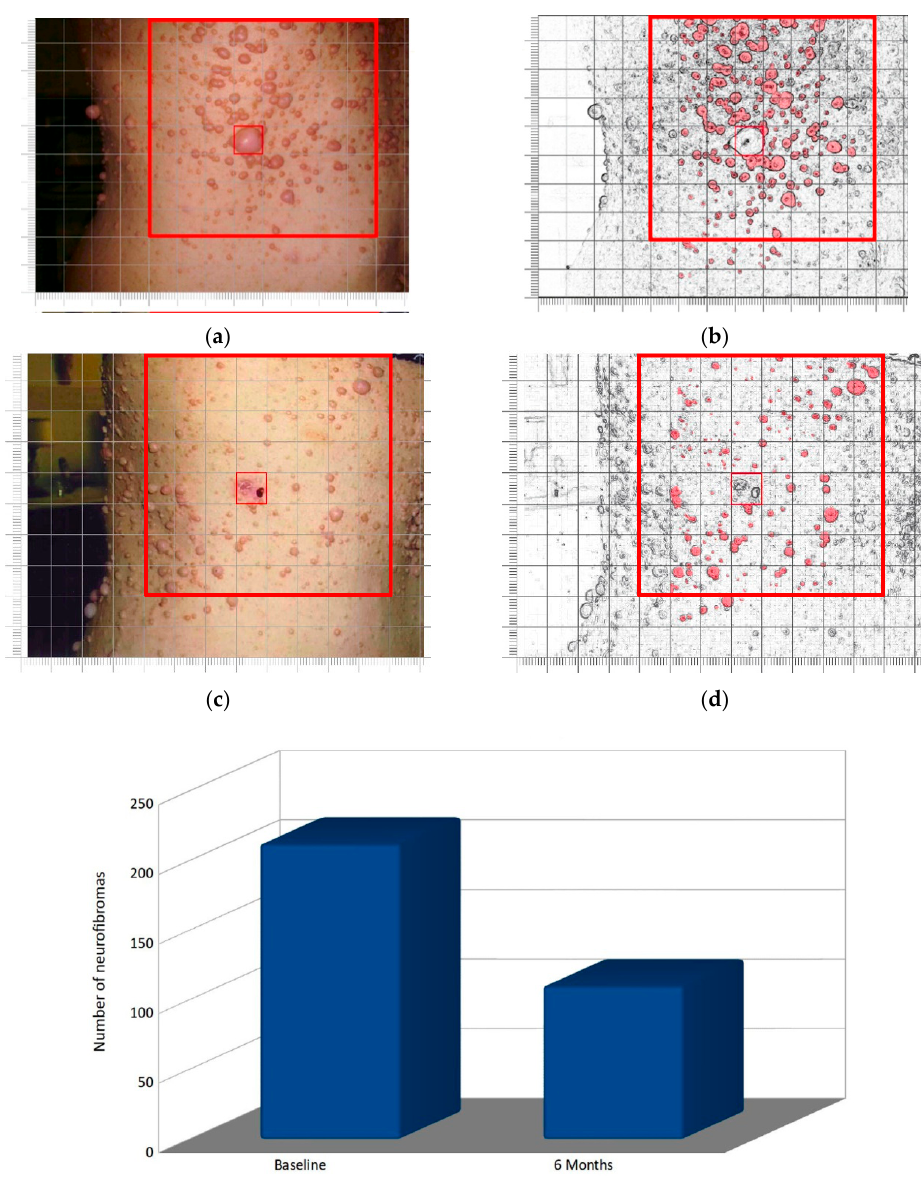
Figure 2. Right lateral view of thoracic region in patient 9: serial clinical assessment. ( a , c ) The large red square outlines the sampled area at baseline ( a ) and after six months of MedDietCurcumin ( c ); the small red square indicates the most prominent neurofibroma in the area, which was removed immediately after baseline observation for histological examination; ( b , d ) Digital re-elaboration of the images in A and C to facilitate manual counting of cutaneous neurofibromas; ( e ) Bar chart representing the number of neurofibromas in the sampled area at baseline and at six-month